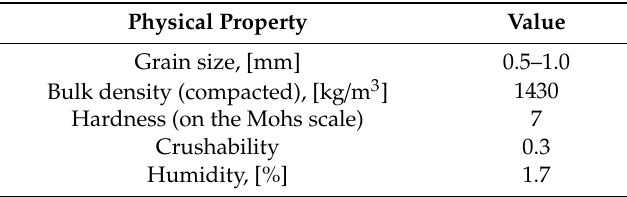
Table 2. Physical properties of silica sand.